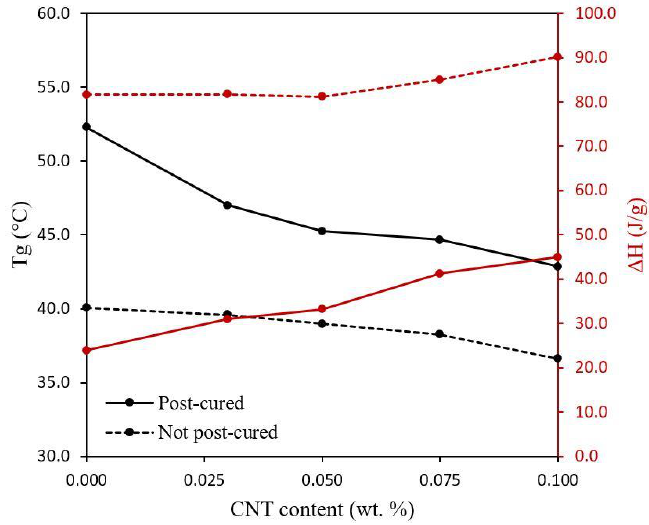
Figure 9. Glass transition temperature ( T g ) and cure enthalpy ( ∆ H) measured by DSC of 3D printed composites as a function of CNT content.